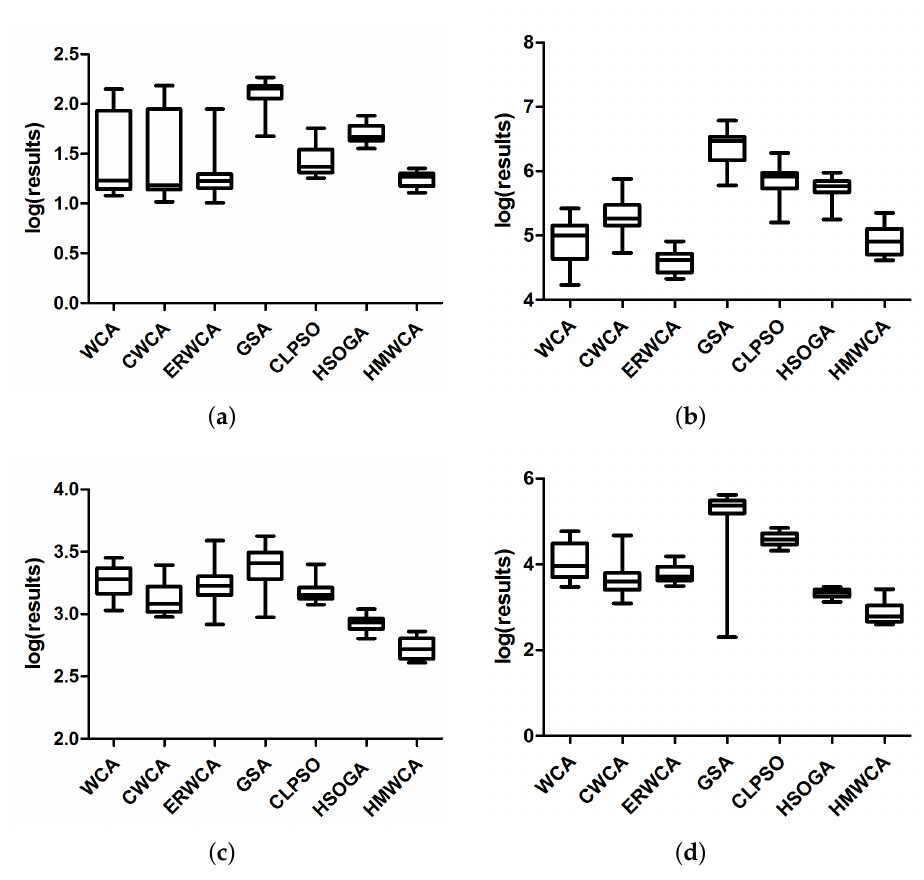
Figure 4. The comparisons of the results of the seven studied algorithms for the functions ( a ) f 19 , ( b ) f 21 , ( c ) f 28 , ( d ) f 30 with D = 30.